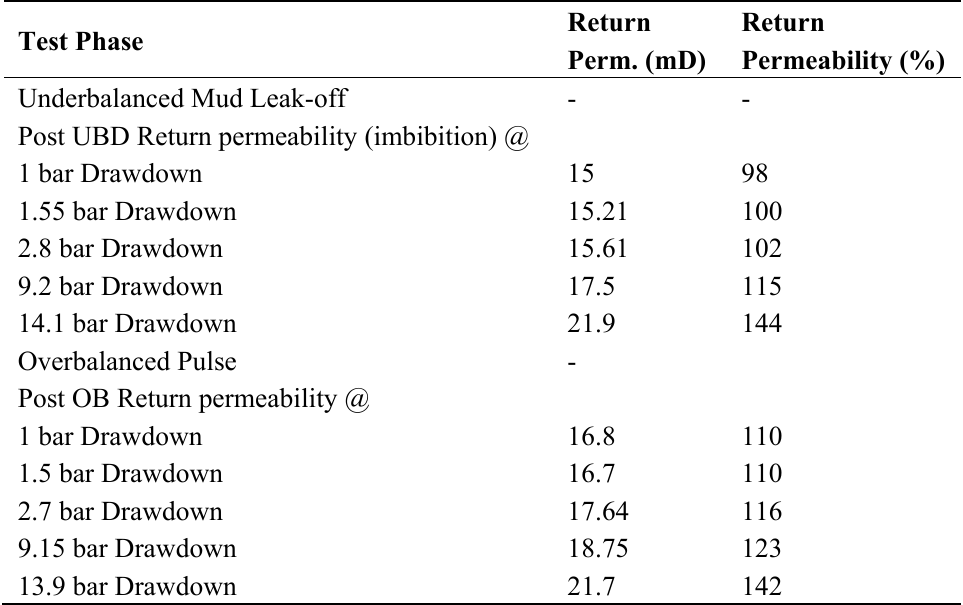
Table 3. UBD leak-off test with lab oil; Sample A, Permeability